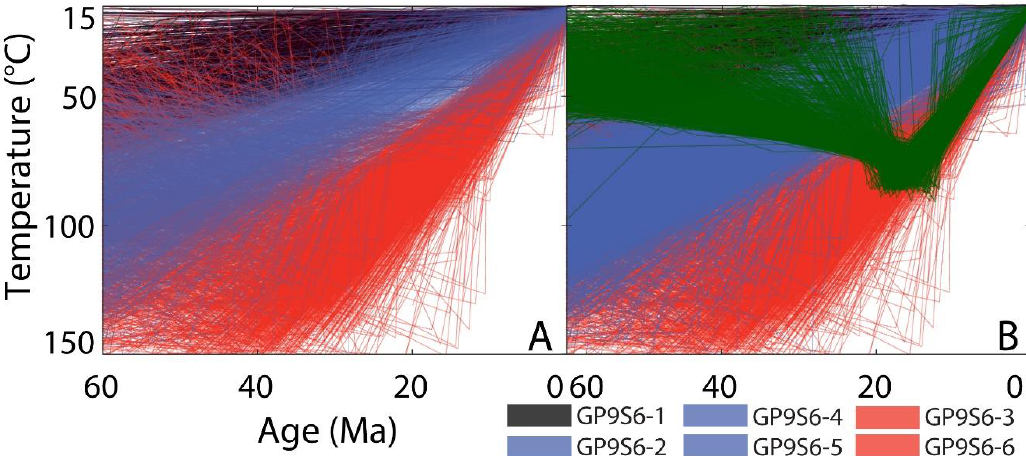
Figure 6. Thermal model results for individual single grain runs from sample GP9S6 of [11]. ( A ). Red represents results for dates not rejected by [11] . Black and blue represent different groupings of dates all rejected by [11]. Results shown as accepted individual time-temperature paths from post “burn in” model iterations. ( B ) Same frame as in ( A ) but with accepted post “burn in” thermal histories from the aggregate 6 grains model shown in green.